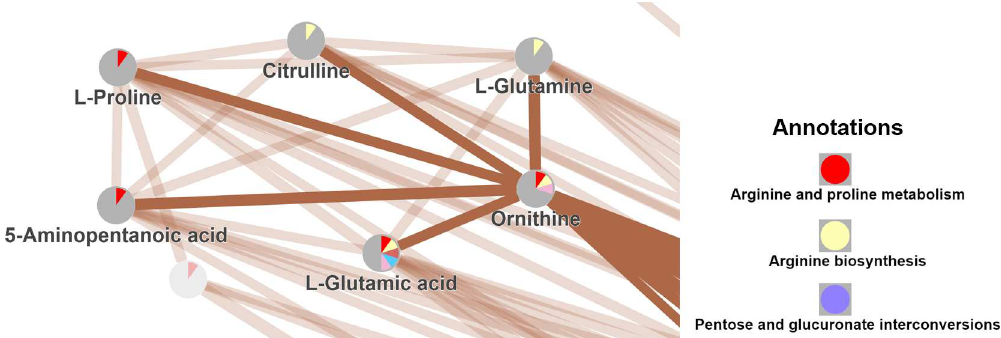
Fig 2. Partial visualization of the entire ‘chemical structure similarity’ network of metabolites in a lung adenocarcinoma study. Chemicalsimilarities betweenall identifiedmetabolites was calculatedfrom PubChem substructurefingerprints.Network nodesare connectedby correlationcoefficientsusing edge thickess for correlations r xy > 0.7. Metabox functionalclass scoring was appliedto estimate significantly enrichedpathways ( p < 0.05),yieldingarginine/proline metabolism, argininebiosynthesis and pentose/glucuronateinterconversions among other pathways. Pathway enrichments are given by color in node pie